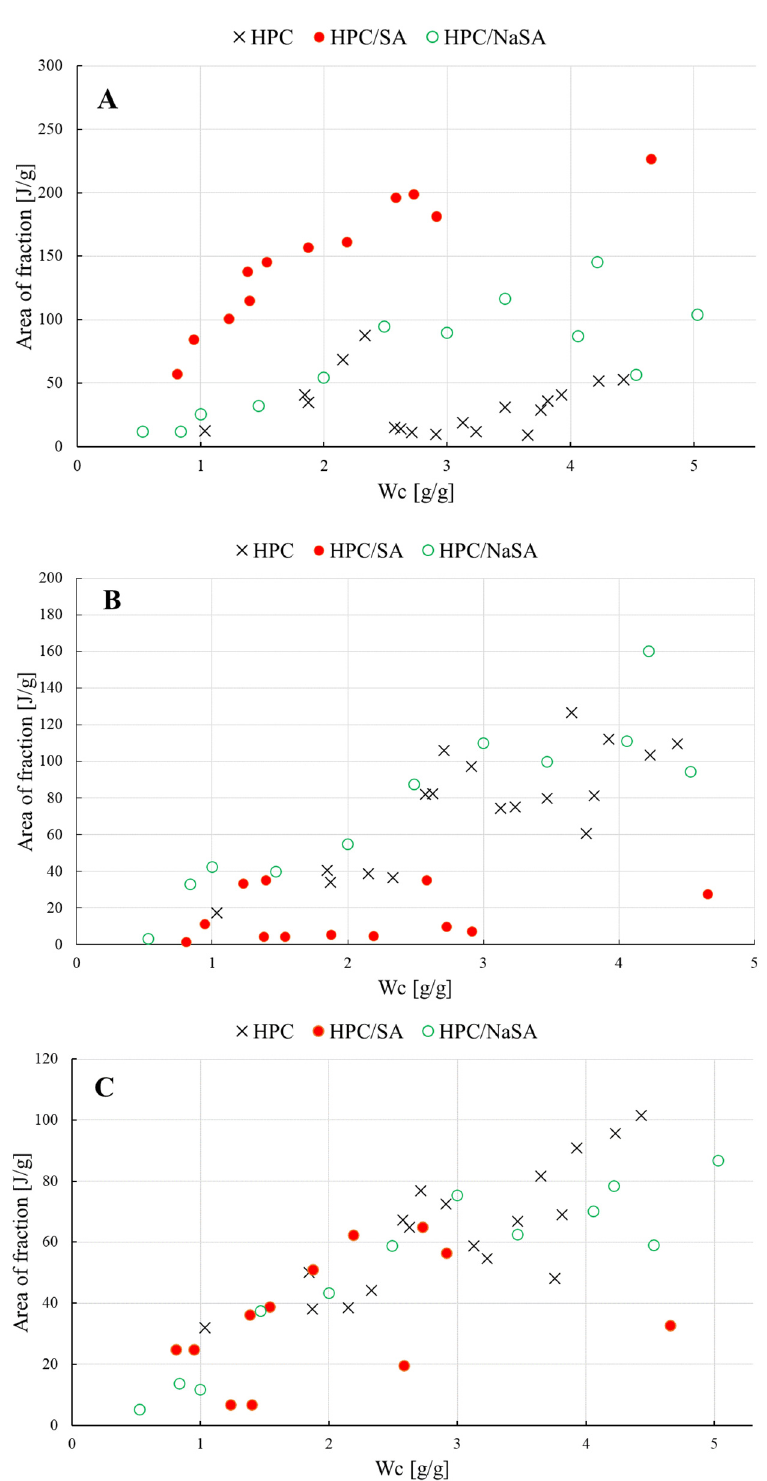
Figure 11. Comparison of all fractions (components) of ( A ) free water (FW), ( B ) freezing bound water (FBW), ( C ) non-freezing water (NFW) to W c The red circles, green empty circles, and grey crosses indicate HPC/SA, HPC/NaSA, and raw HPC, respectively.